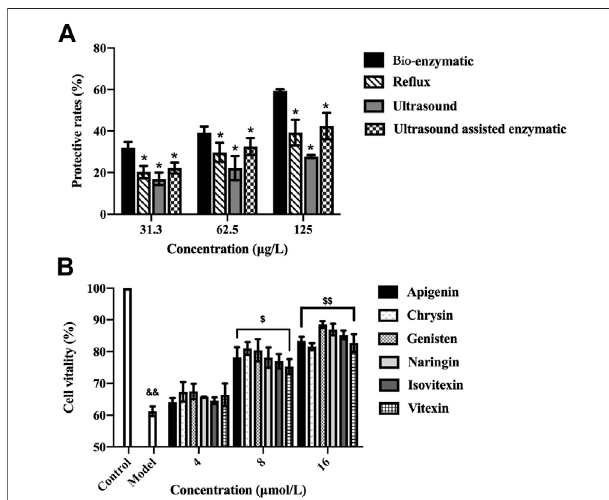
FIGURE4|(A) Hepatoprotectiveeffectsofthetotal fl avonoidsextracted by re fl ux, ultrasonic, ultrasound-assisted enzymatic method (TFH) and bio- enzymatic method (Ey-TFH). * p < 0.05, compared with Ey-TFH. Data of Figure 4A were submitted simultaneously to Fourth International Scienti fi c Conference ” Alternative Energy Sources, Materials and Technologies(AESMT ′ 21)"14thJune15thJune2021,Ruse,Bulgaria. (B) Cell viability after exposure to various concentrations of six differential components. && p < 0.01, compared with the control group; $ p < 0.05, $$ p < 0.01, compared with the model